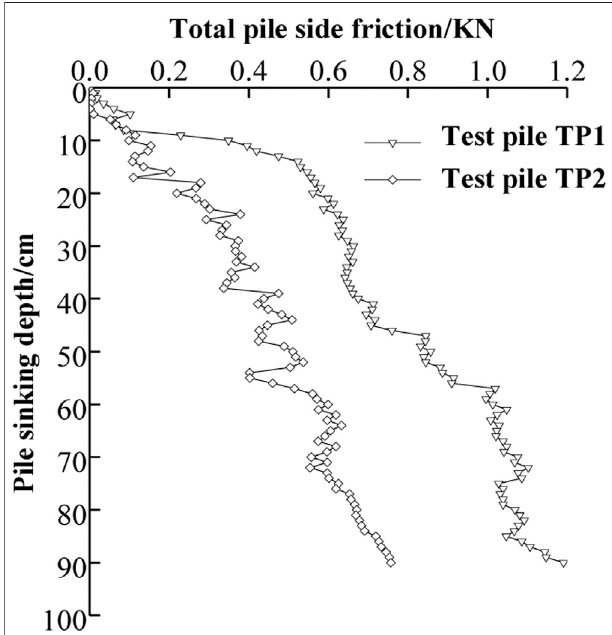
FIGURE 10 | Variation of the side resistance of the total pile during pile jacking.